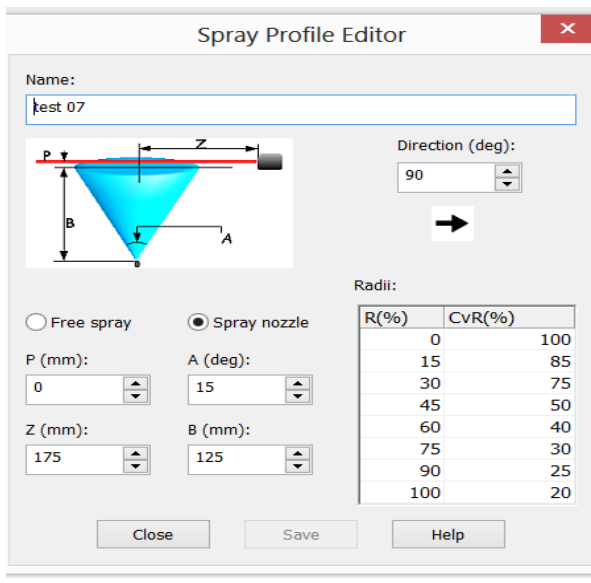
Fig. 6. Dialog box screen shot for differential and integral distribution of fuel